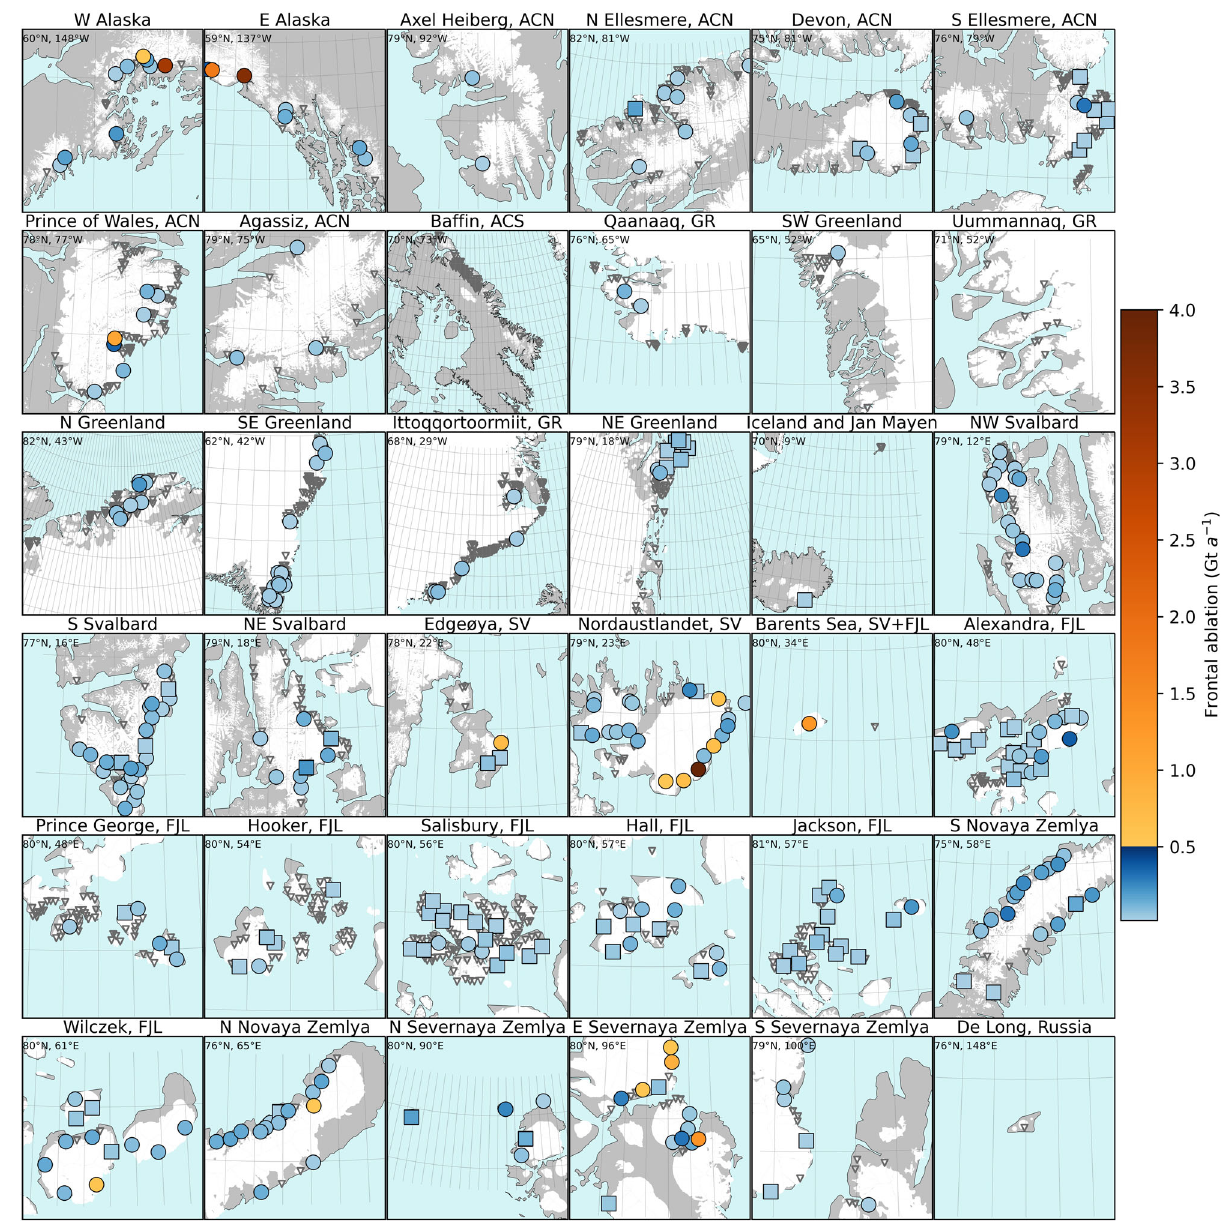
Fig. 2 | Meanfrontal ablationrate by glacier for 2010 – 2020. Dark graytriangles indicate glaciers that have a frontal ablation <0.02Gta − 1 (not shown in color bar) and squares indicate glaciers where the uncertainty is more than 50% of total frontal ablation. Glacierized area is marked in white. Latitude and longitude in top leftofeachpanelindicatethecenterpointofthatpanelandthegridis1°by1°forall panels, with 1 degree of latitude equal to 111km. The only glacier off the color bar